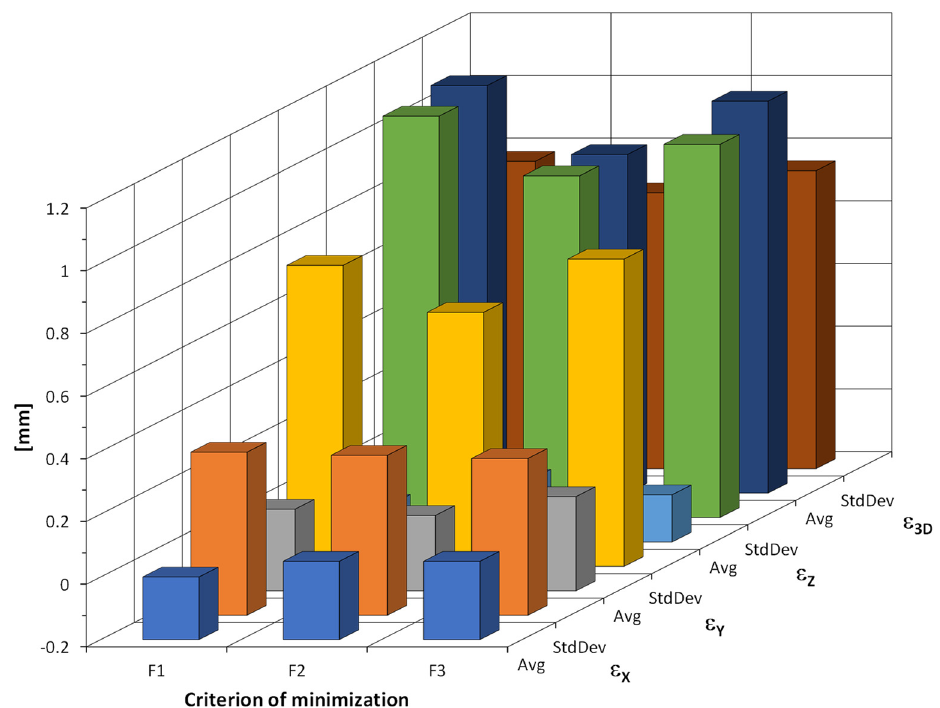
Figure 11. Values of basic statistics describing the distributions of coordinate deviations of the points obtained from measurements for transformation parameters resulting from minimization of the considered objective function.